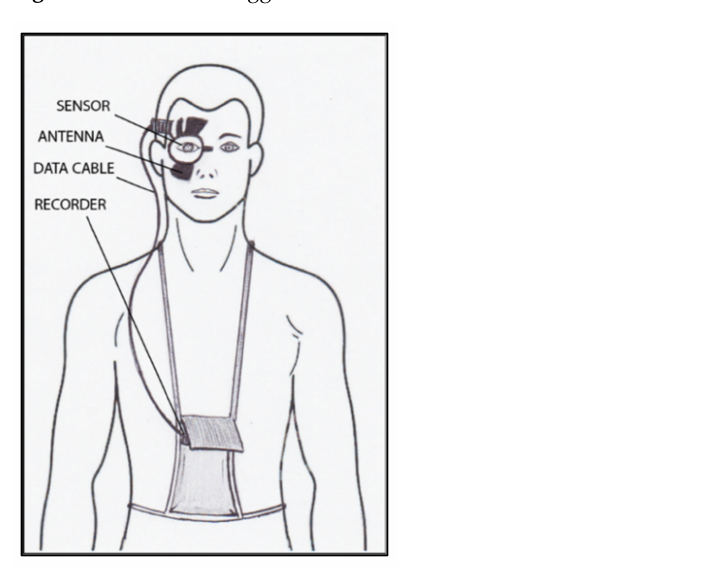
Figure 17. Sensimed Triggerfish.